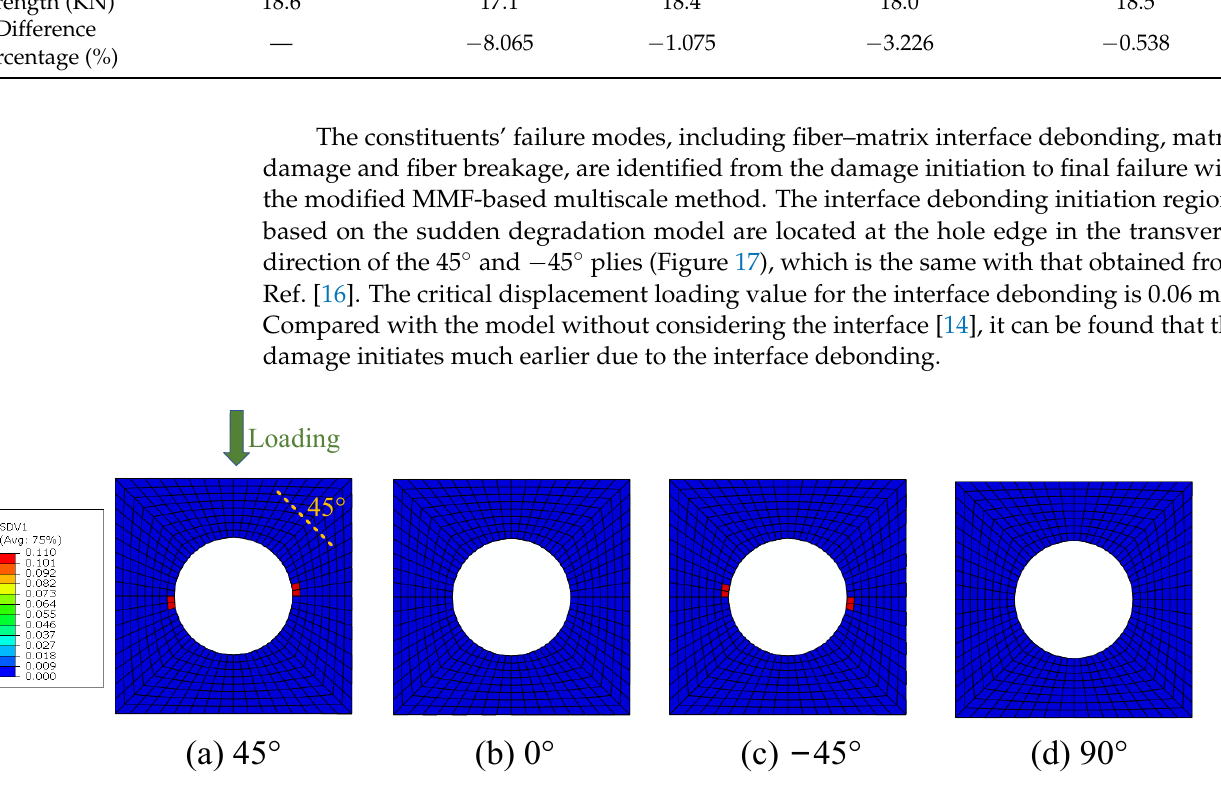
Figure 18. Intralaminar shear stress distribution pattern. In the analyses conducted in Refs. [3–11], only the damage propagation processes at the macroscale were obtained and analyzed. With the modified MMF multiscale method developed in this study, besides the obtained macroscale results, the microscale infor- mation can also be obtained. With the amplification factors, the failure indices and stress states of the constituents are obtained and mapped into the microscale RVE, which would be helpful for revealing the failure mechanisms more clearly. For the macroscale element where the interface debonding initiates first in the 45° ply, the failure indices and the traction distribution patterns in the corresponding interface regions are shown in Figure 19. It can be found that, in the normal direction, the compres- sive traction is subjected. Based on the interface debonding criteria, it can be concluded that the interfacial debonding at the location shown in Figure 17 is independent on the normal traction value. Comparing the longitudinal shear traction with tangential shear traction distribution patterns, it can be found that it is the longitudinal shear traction that makes the most contribution to the interface failure. From the distribution pattern of fail- ure indices, it can be found that the interface debonding initiates uniformly due to the interaction of the fibers. Besides the damage initiation position, the damage propagation process at the microscale can also be obtained. With the increase in displacement loading, the interface debonding regions increase quickly at the microscale (Figure 20).